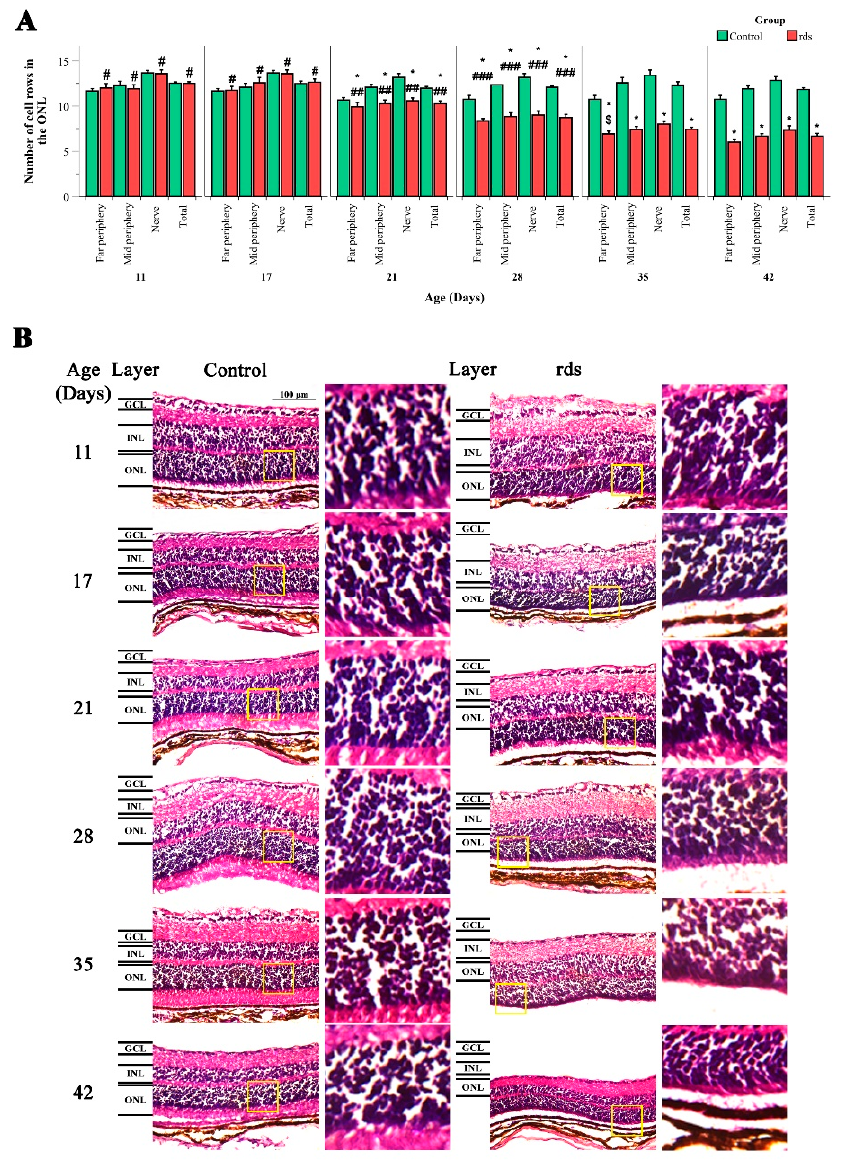
Figure 1. Rows of photoreceptor nuclei in the retinal ONL of control and rds mice. ( A ) Mean number of photoreceptor rows in the control and rds mice; error bars correspond to the standard error of the mean (* p < 0.01 vs. control group at the same age; # p < 0.0001 vs. rds at PN21, PN28, PN35, and PN42; ## p < 0.0001 vs. rds at PN28, PN35, and PN42; ### p < 0.05 vs. rds at PN35 and PN42; $ p < 0.02 vs. rds at PN42). Four mice per group were used and three histological sections of one retina of each mouse were quantified. ( B ) Retinal hematoxylin–eosin staining of control and rds mice at PN11, PN17, PN21, PN28, PN35, and PN42 in the midperiphery retina.